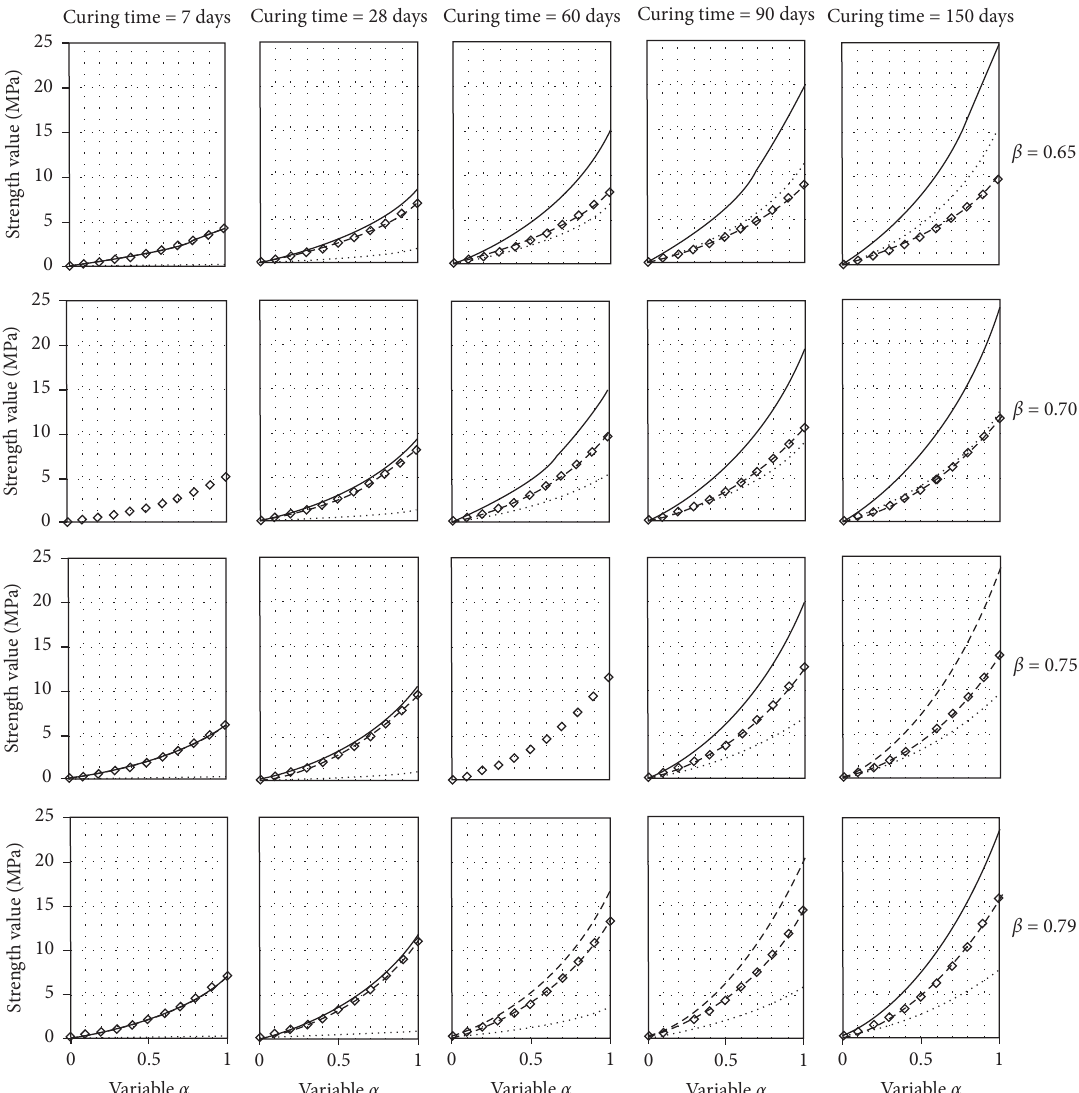
Figure 6: Resultant unconfined compressive strength (UCS) predicted under various combinations of binder concentration ( α ) and cement fraction in the binder ( β ). Dashed curves with square marks: strength contributed from the OPC component (equation (2)); dashed curves: strength contributed from the fly ash component (equation (3)); solid curves: UCS of PFC-stabilized clay (equation (2) plus equation